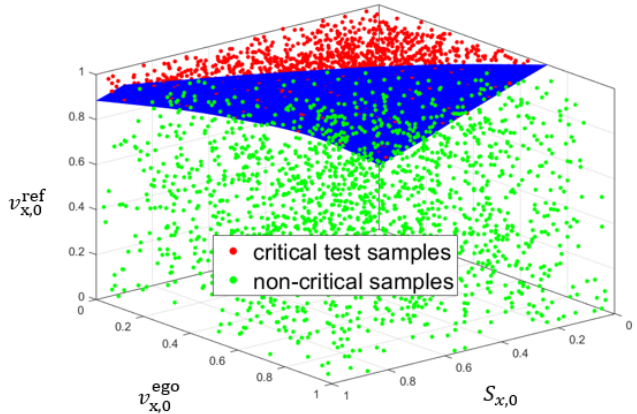
Figure 12. The performance boundary and test samples. The blue surface is the performance boundary between critical and non-critical scenarios. Red circles are critical scenarios, while green circles are non-critical scenarios. To enhance the visualization, we only display 2% of non-critical and 20% of critical scenarios from the test dataset.